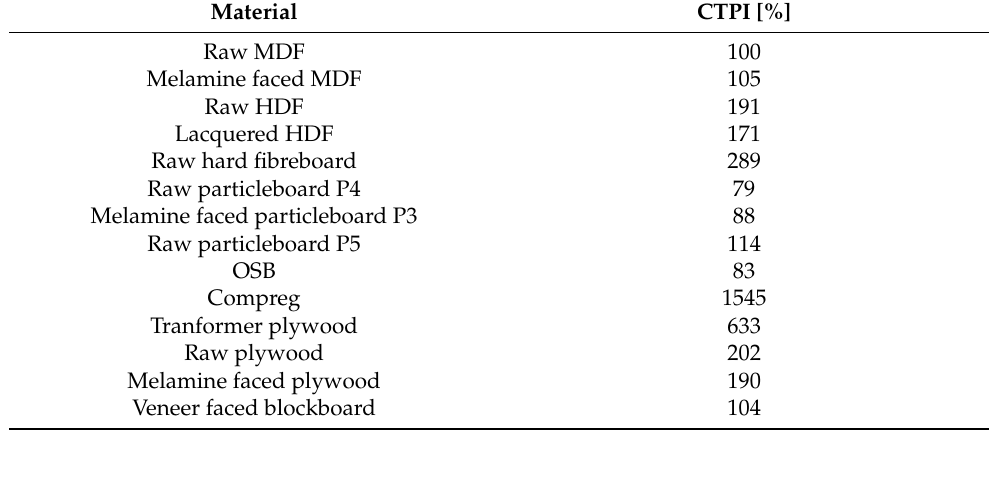
Table 2. The numerical values of the cutting time problem index (CTPI).